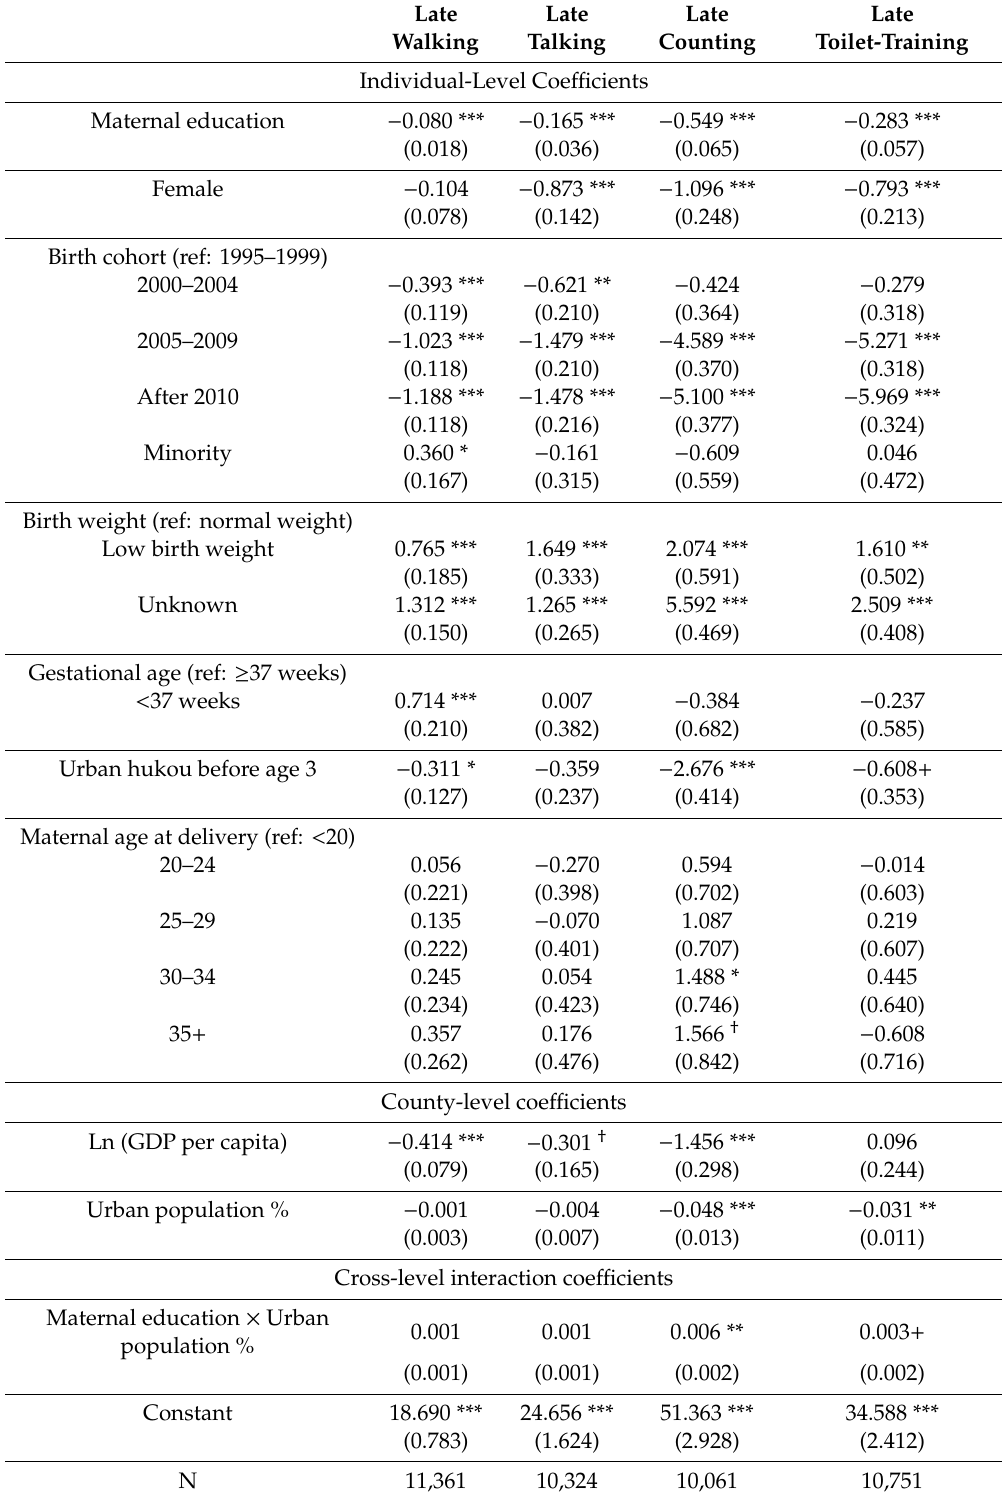
Table A5. Two-level Regression Models of Early Developmental Milestones on Individual and County-level Variables.